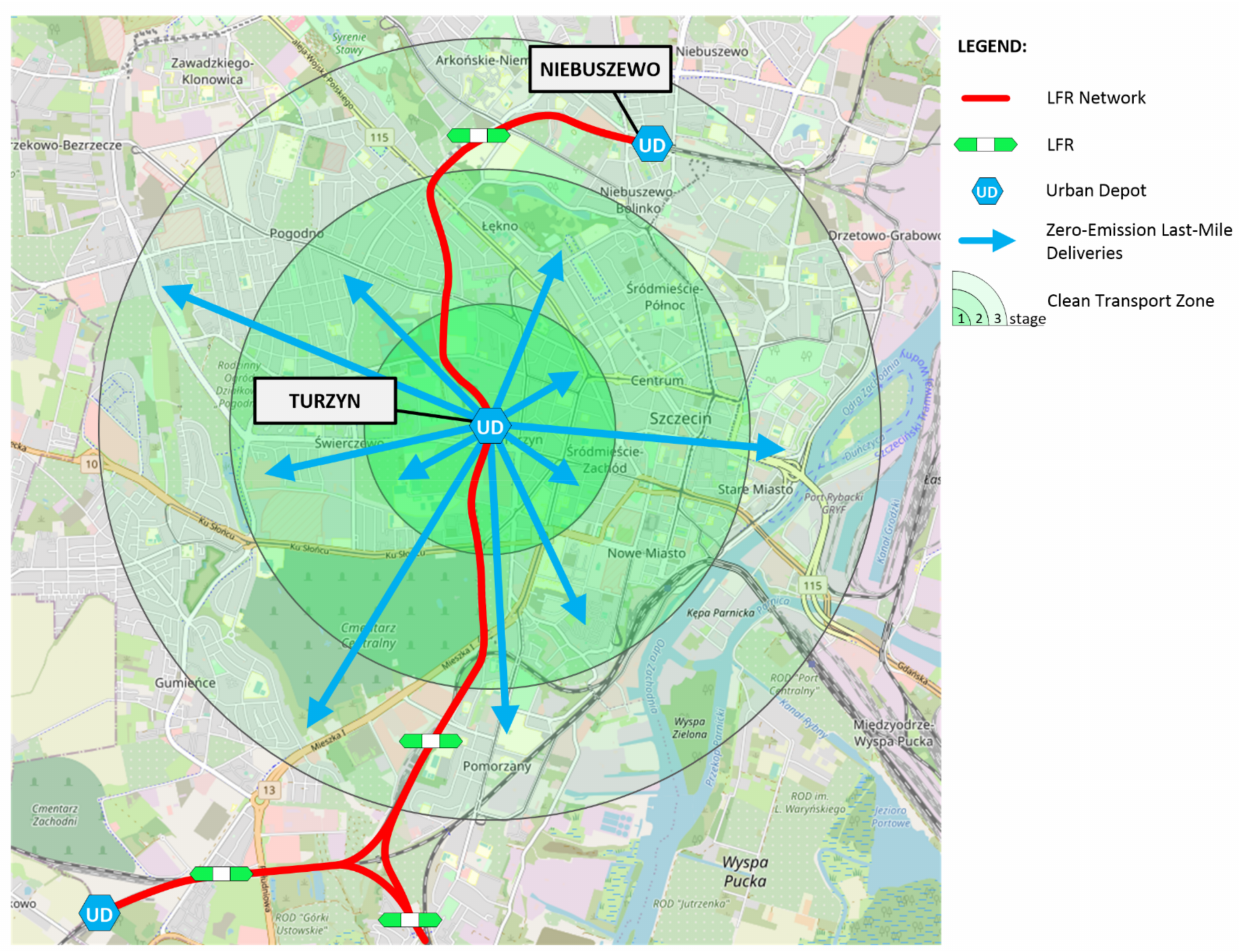
Figure 6. Scenario of CTZ expansion in the case LFR is used (variant V1) to make deliveries to UD Turzyn in